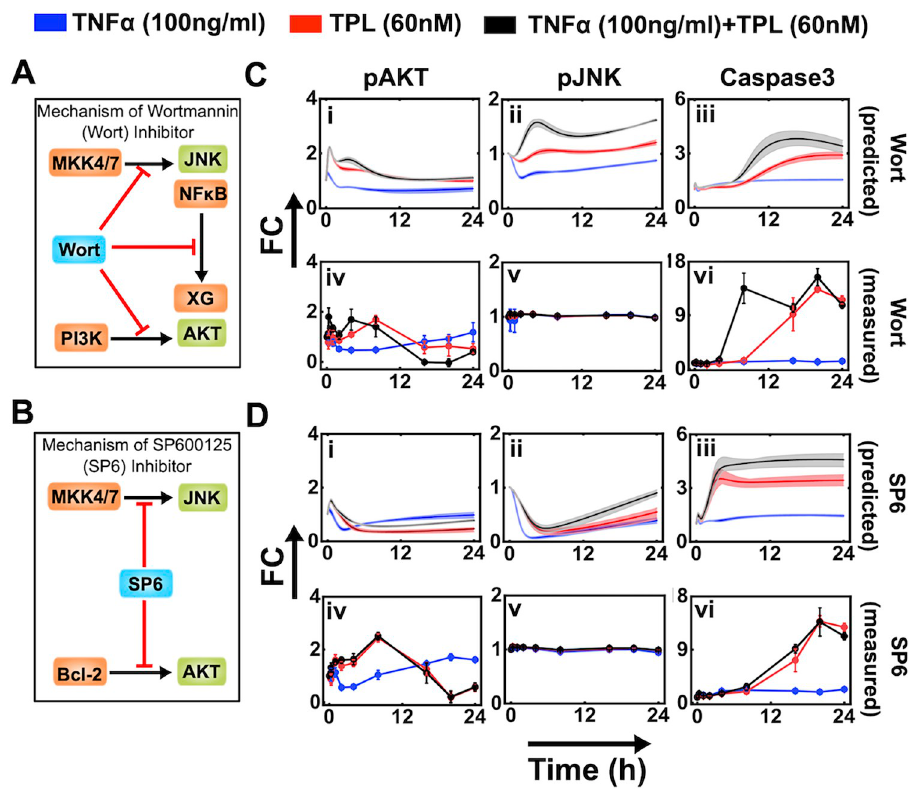
Fig 6. Model prediction and experimental validation of the marker proteins under the treatment of Wortmannin (Wort) and SP600125 (SP6) inhibitor. (A) and (B), respectively schematically represents the inhibitory action of Wort and SP6. (C) Effect of Wort inhibition on (i) pAKT, (ii) pJNK, and (iii) Caspase3 as predicted by model simulations. The corresponding experimental validations are in (iv), (v), and (vi), respectively. (D) Effect of SP6 inhibition on (i) pAKT, (ii) pJNK, and (iii) Caspase3 as predicted by model simulations. The corresponding experimental validations are in (iv), (v), and (vi), respectively. The rate constant values used for the inhibitory interactions are given in the caption of S12 and S13